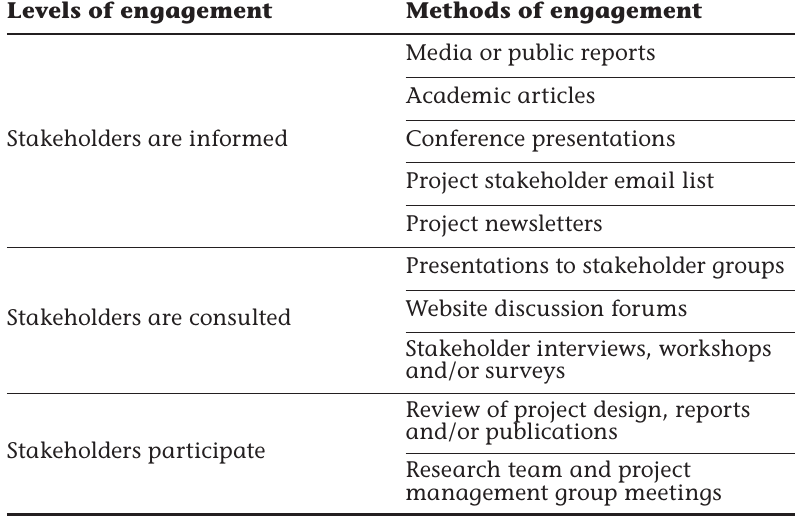
Table 1: Levels of, and methods for,